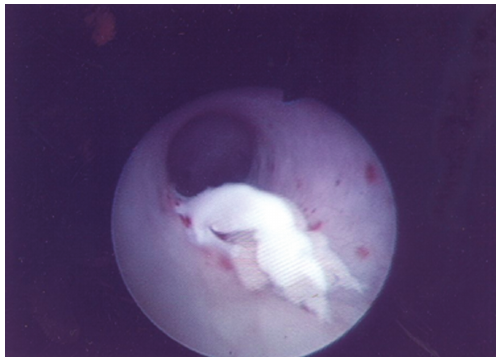
Figure 4: Macroscopic view of base of the fibroepithelial polyp of the kidney following excision with 25mm Amplatz GOOSE NECK Snare.